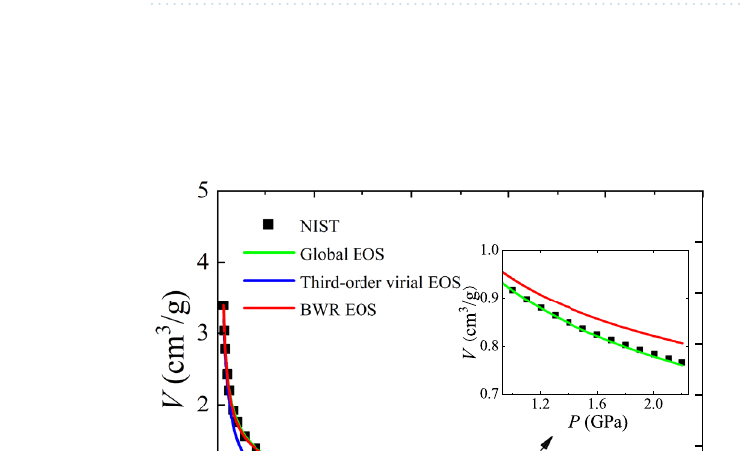
Figure 2. Verification of the global EOS using 4 He data and comparison with the ideal gas and ideal dense matter EOS. ( a ) Entropy versus pressure at 300 K; ( b ) Entropy versus temperature at 1.6 GPa; ( c ) Volume versus pressure at 80 K; ( d ) Volume versus temperature at 2 GPa.